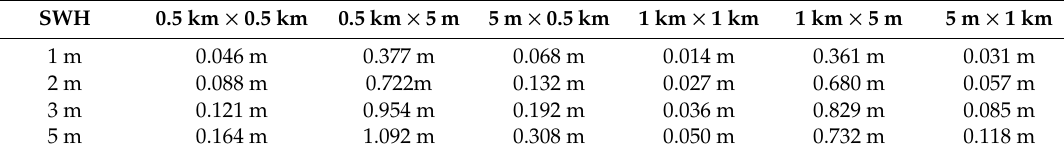
Table 12. The RMS of smoothing layover height inversion results with di ff erent SWH (the direction of the smoothing window is in two directions at the same time, in the azimuth and in the range). SWH